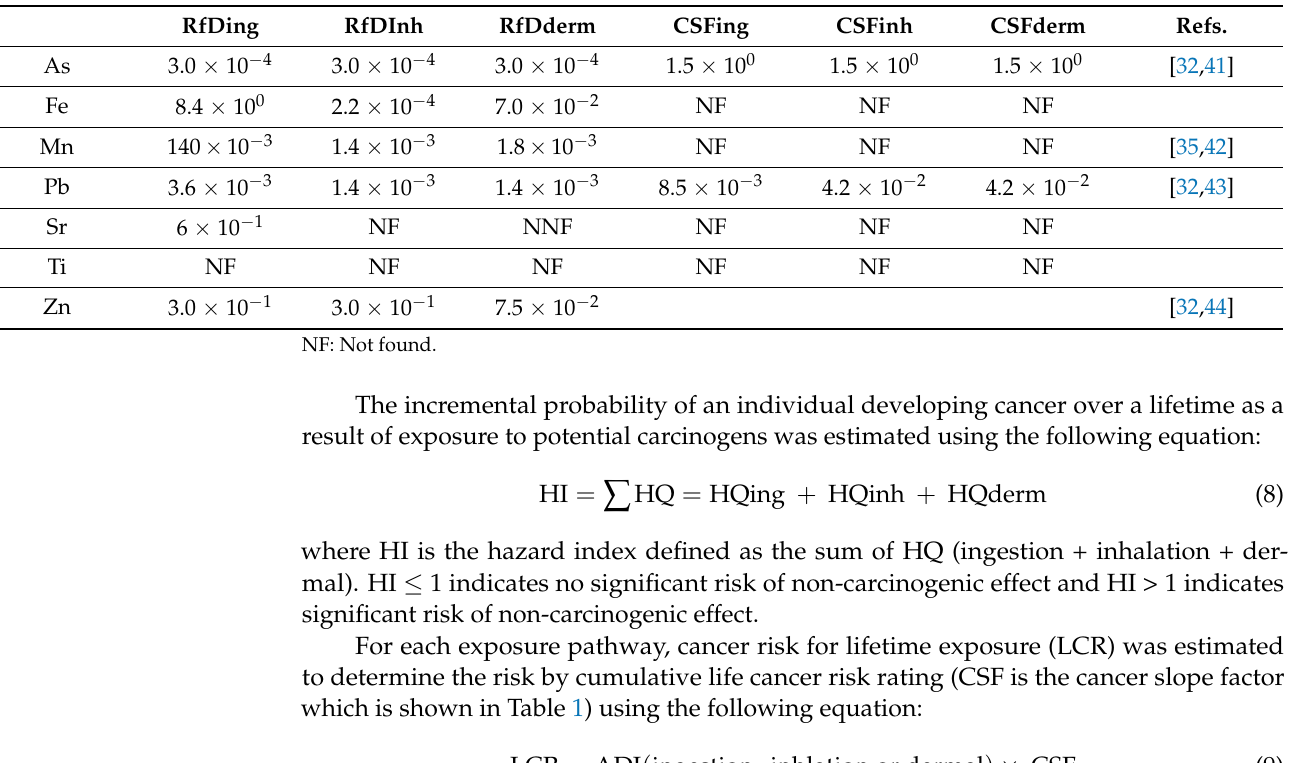
Table 1. Reference doses (mg/kg/day) and cancer risk factors for heavy